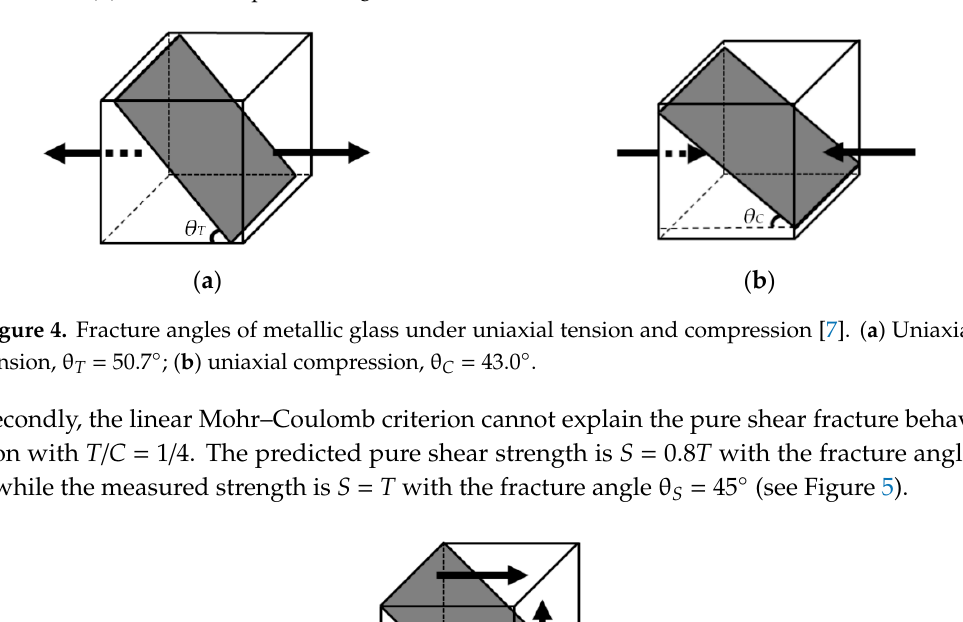
Figure 3. Fracture angles of cast iron under uniaxial tension and compression [6]. ( a ) Uniaxial tension, θ T = 90.0°; ( b ) uniaxial compression, θ C = 37.0°.